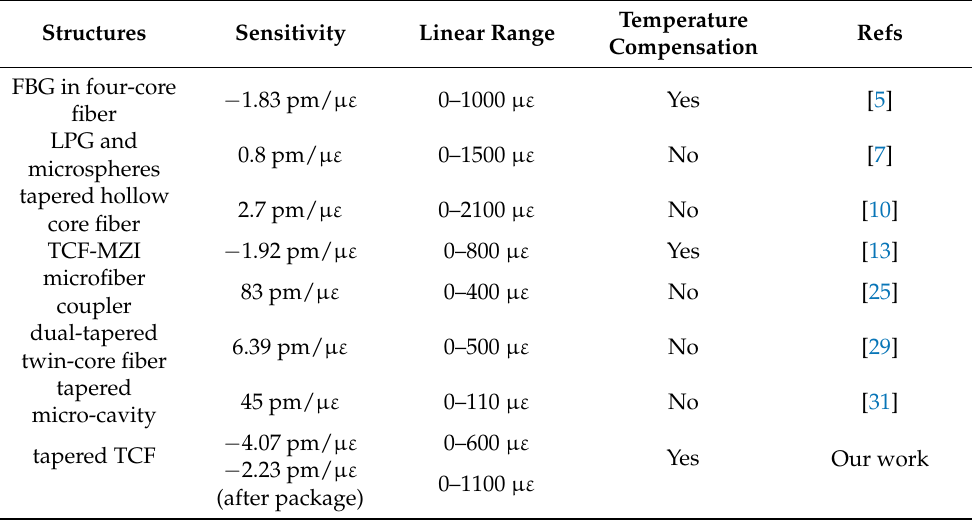
Table 1. Performance comparisons of the reported fiber-optic strain